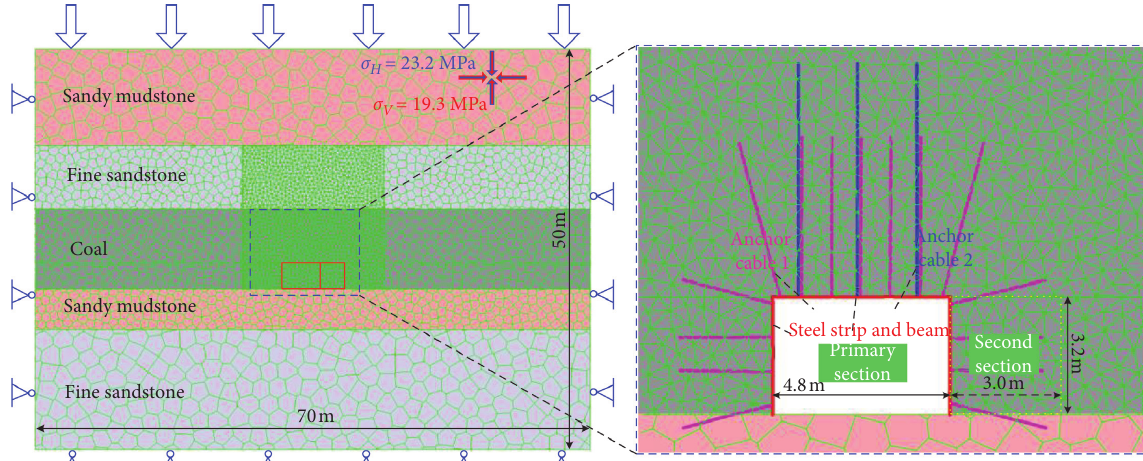
Figure 5: UDEC Trigon model of the LODM containing geometry and boundary conditions.